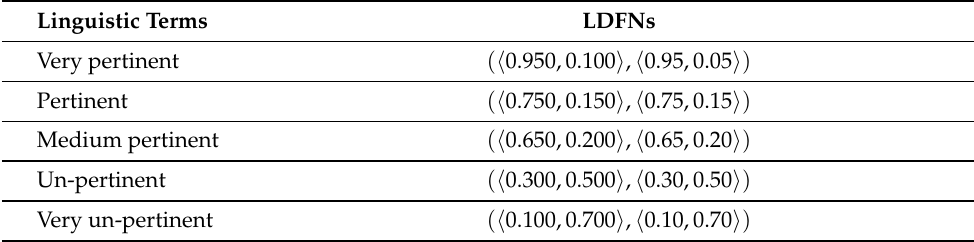
Table 2. LTs for